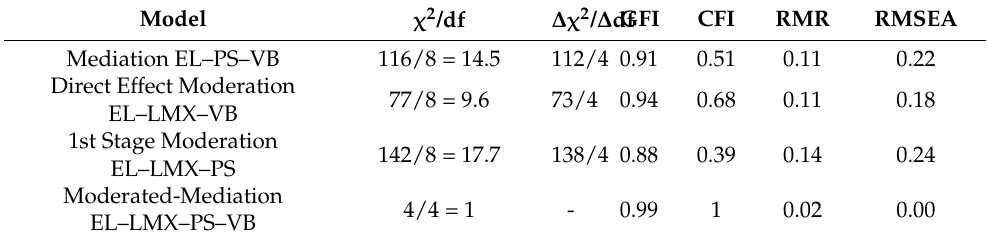
Table 3. SEM model